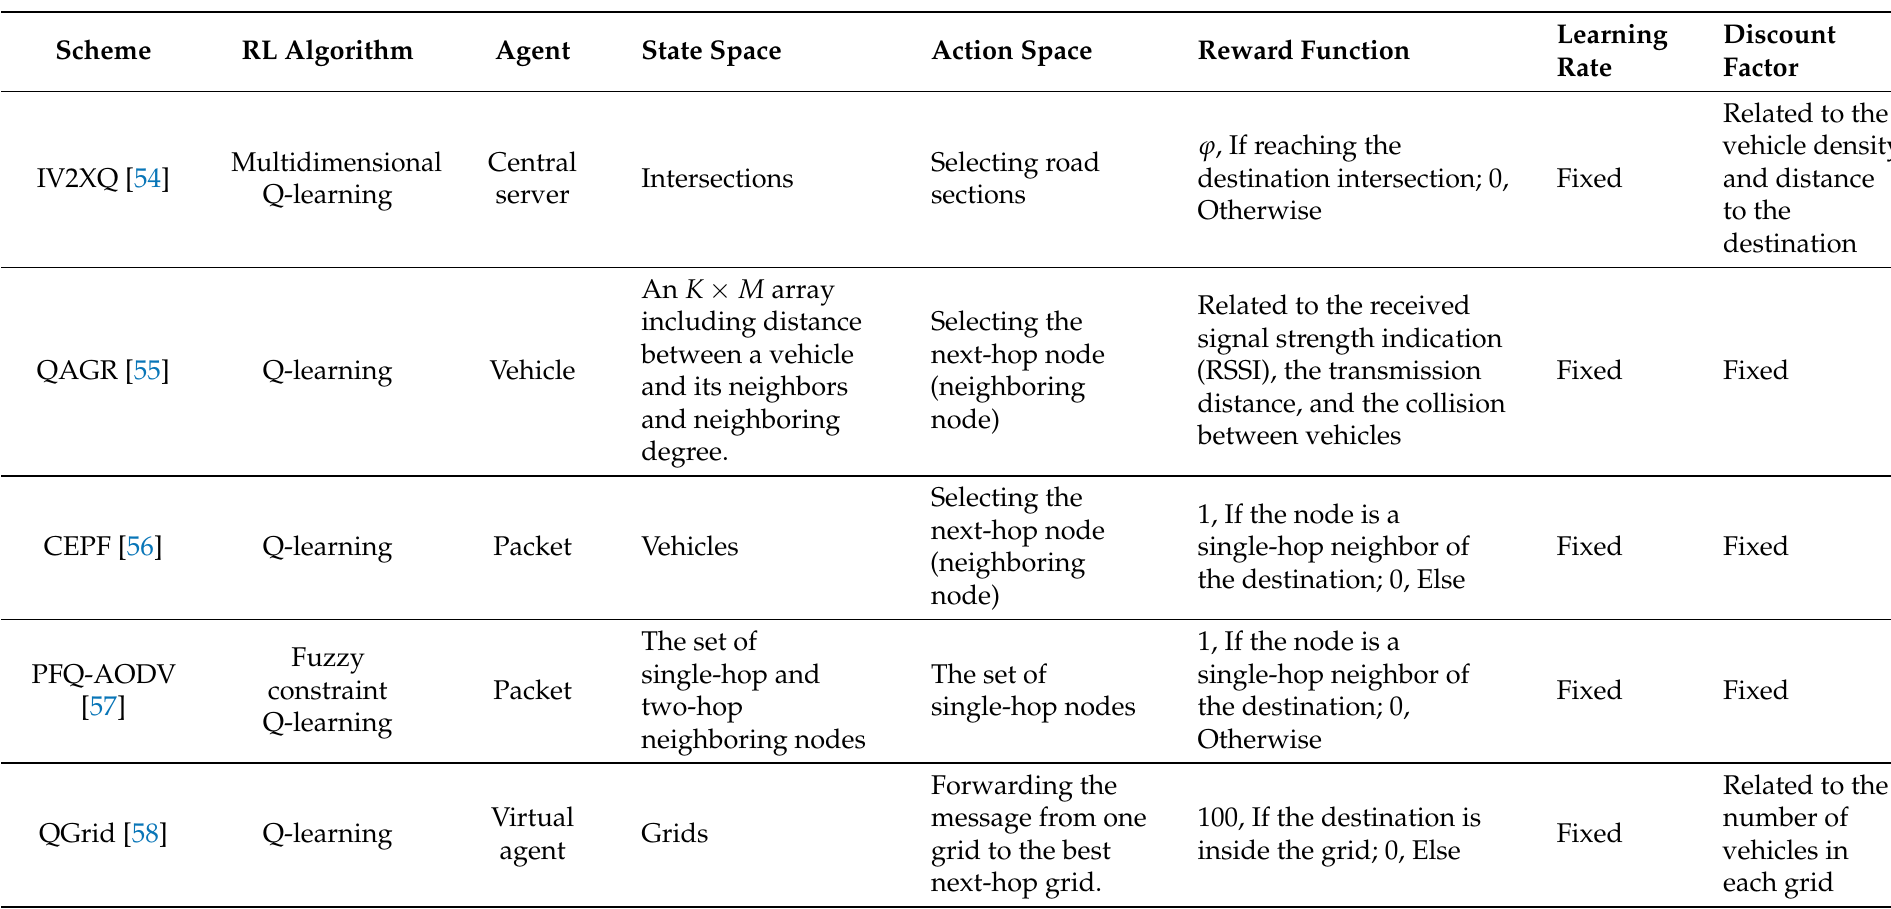
Table 8. Most important features of RL-based routing